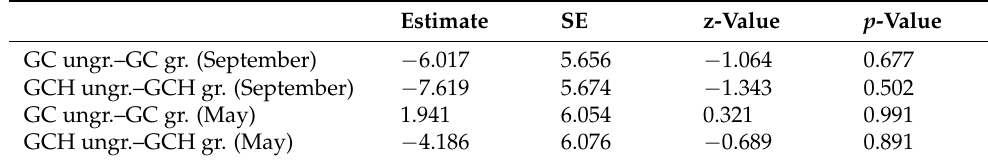
Table A19. Differences in beetle activity densities, comparing the grazed pastures and ungrazed strips of the grass–clover (GC) and the grass–clover herbs (GCH) in May/June and September.